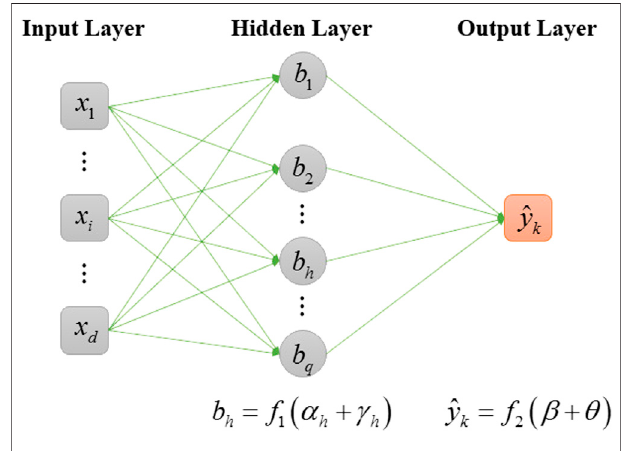
FIGURE 6 | Basic structure of BP neural